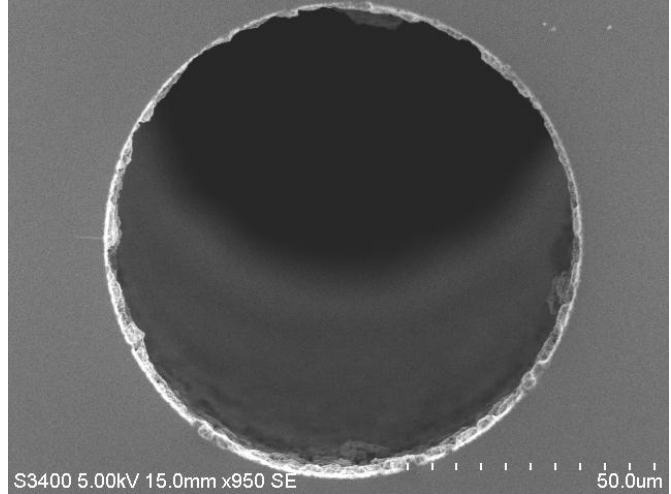
Figure 1. Scanning electron microscopy (SEM) image of a low porosity 1 µm polymer (polystyrene -co- divinylbenzene) monolithic layer formed inside a 75 µm ID fused silica capillary. The structure itself (i.e., the porous layer within the capillary) is referred to as a “monoPLOT” column.